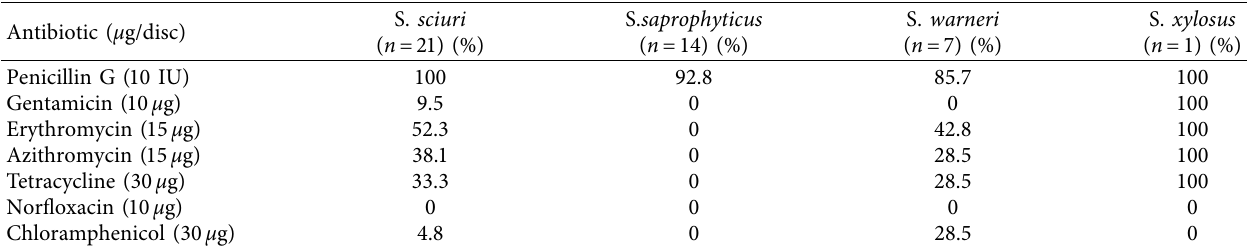
Table 4: Antibiotic resistance of Staphylococcus spp. ( n � 43) isolated from milk and milk products sold in various outlets in Juja Sub-County,